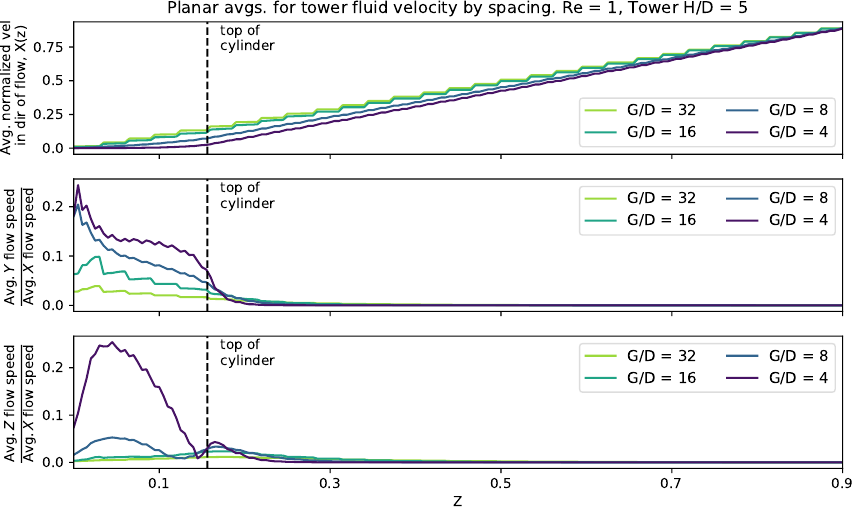
Figure 9. Magnitude of flow velocity averaged across planes perpendicular to the z -axis for different cylinder spacing. The top of the cylinders is plotted as a vertical dashed